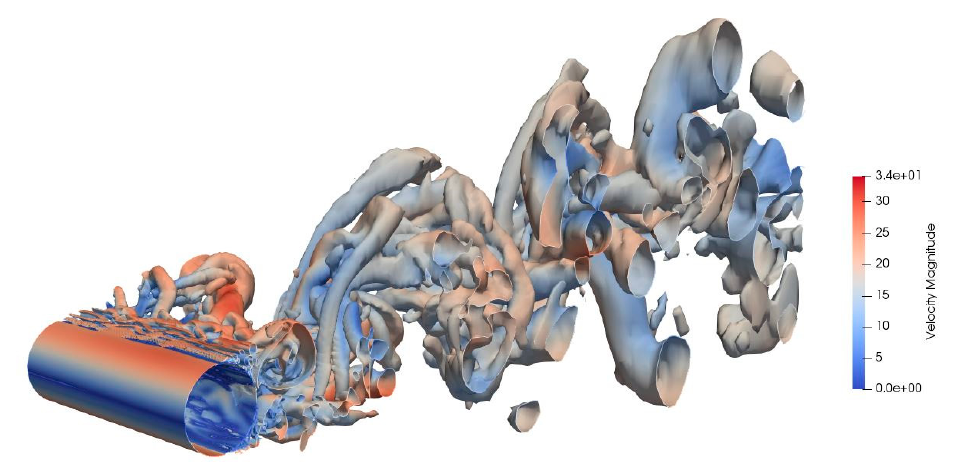
= 500 ( f ε = 1.0, f = 0.5 ) k